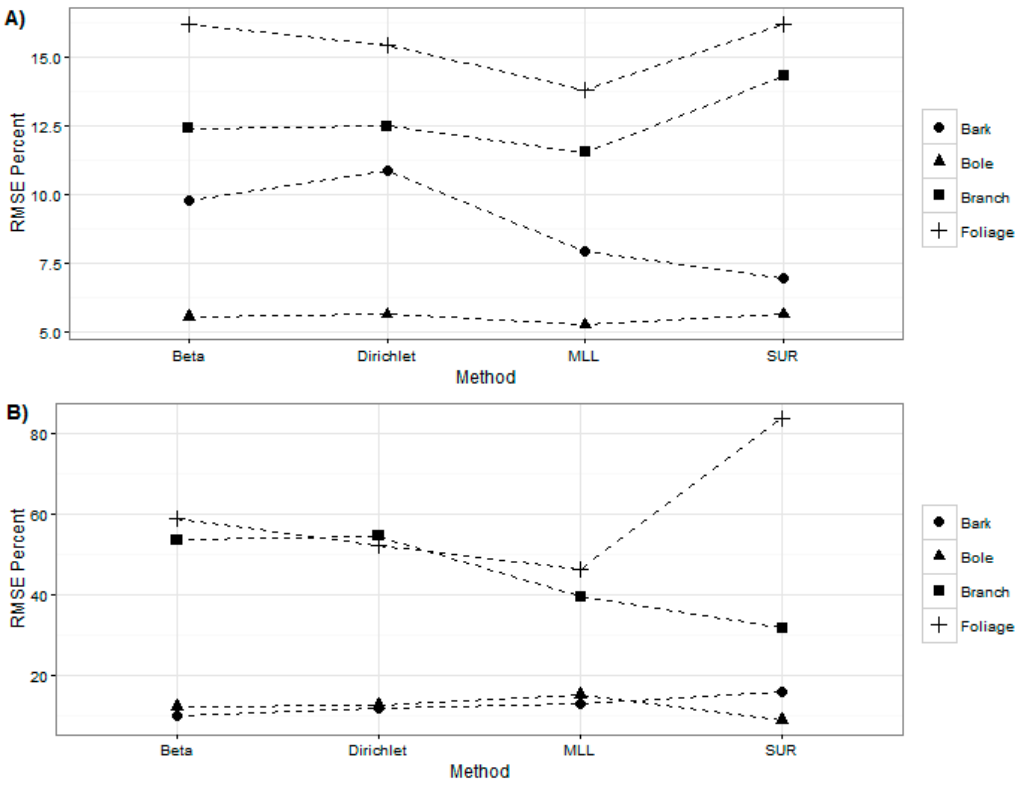
Figure 2. Comparison of root mean square error percent obtained by using beta, Dirichlet, multinomial log-linear, and seemingly unrelated regressions to estimate component of aboveground biomass in ( A ) Western hemlock and ( B ) red alder